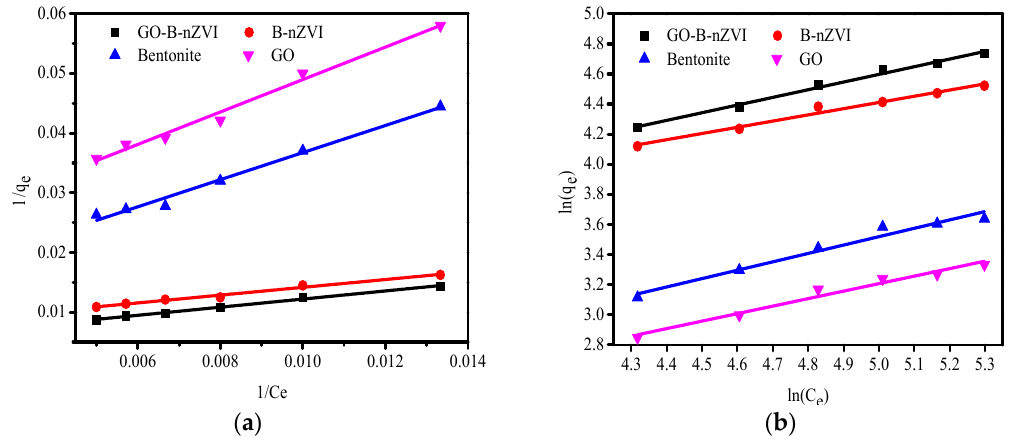
Figure 11. The Langmuir fit and Freundlich fit curve of bentonite, GO, B-nZVI, and GO-B-nZVI for copper ions absorption: ( a ) Langmuir model; ( b ) Freundlich model.